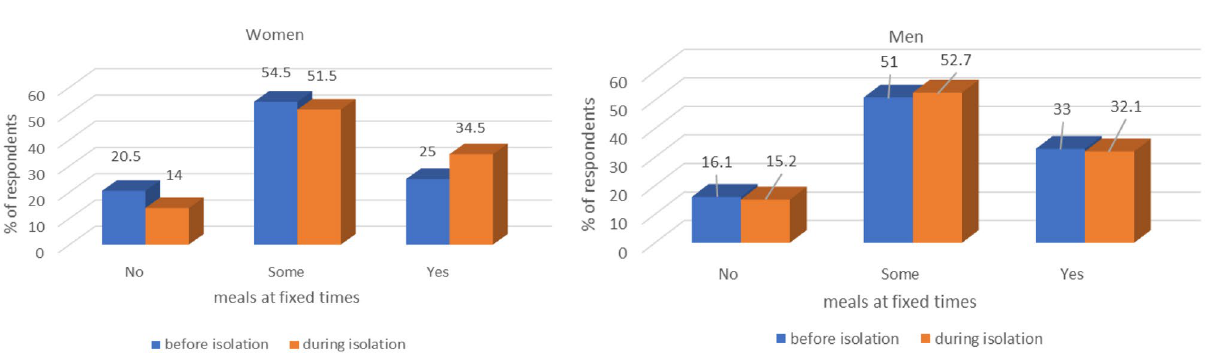
Figure 3. Meals eaten at fixed times by men and women before and during